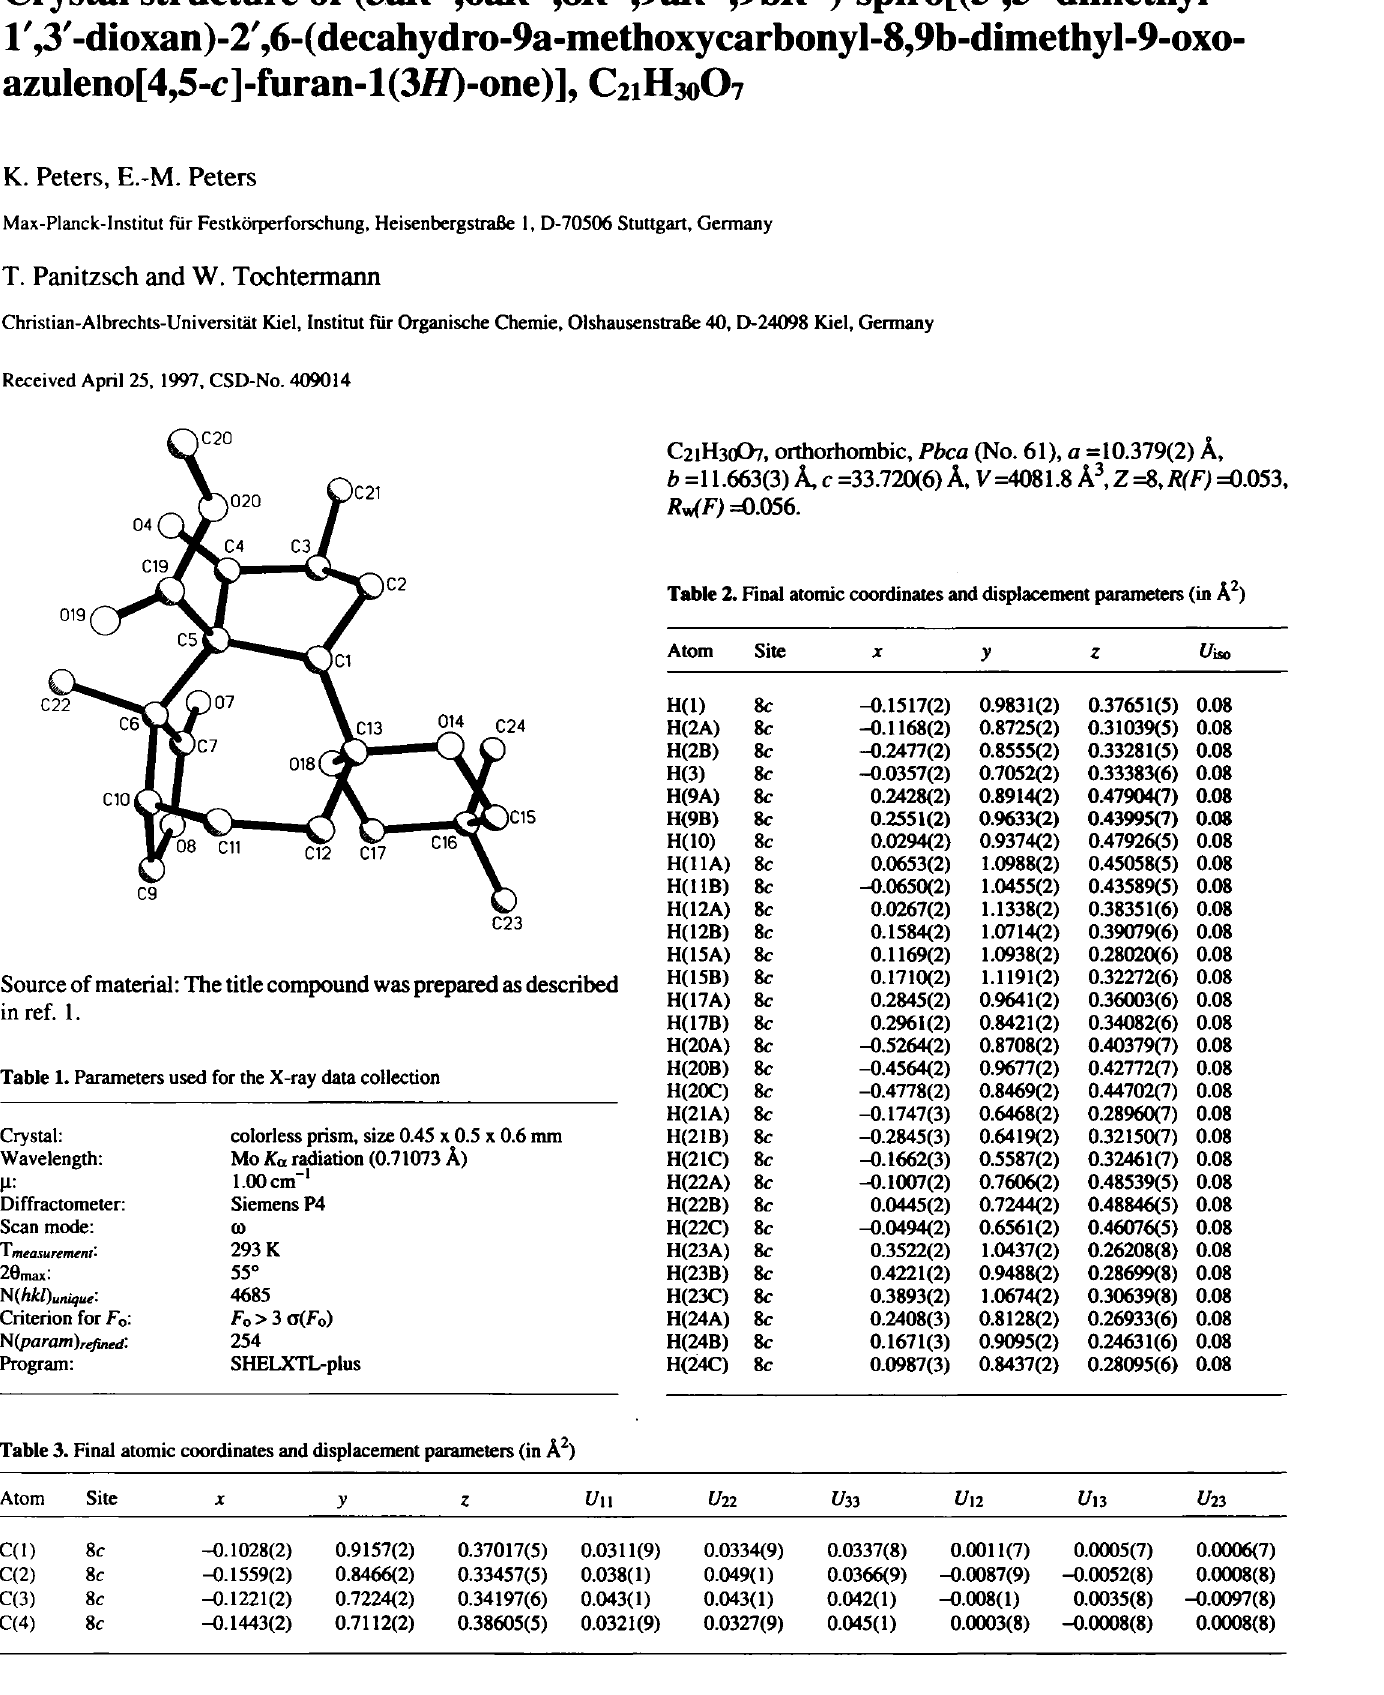
С21Н301О7, orthorhombic, Pbca (No. 61), a =10.379(2) Â,